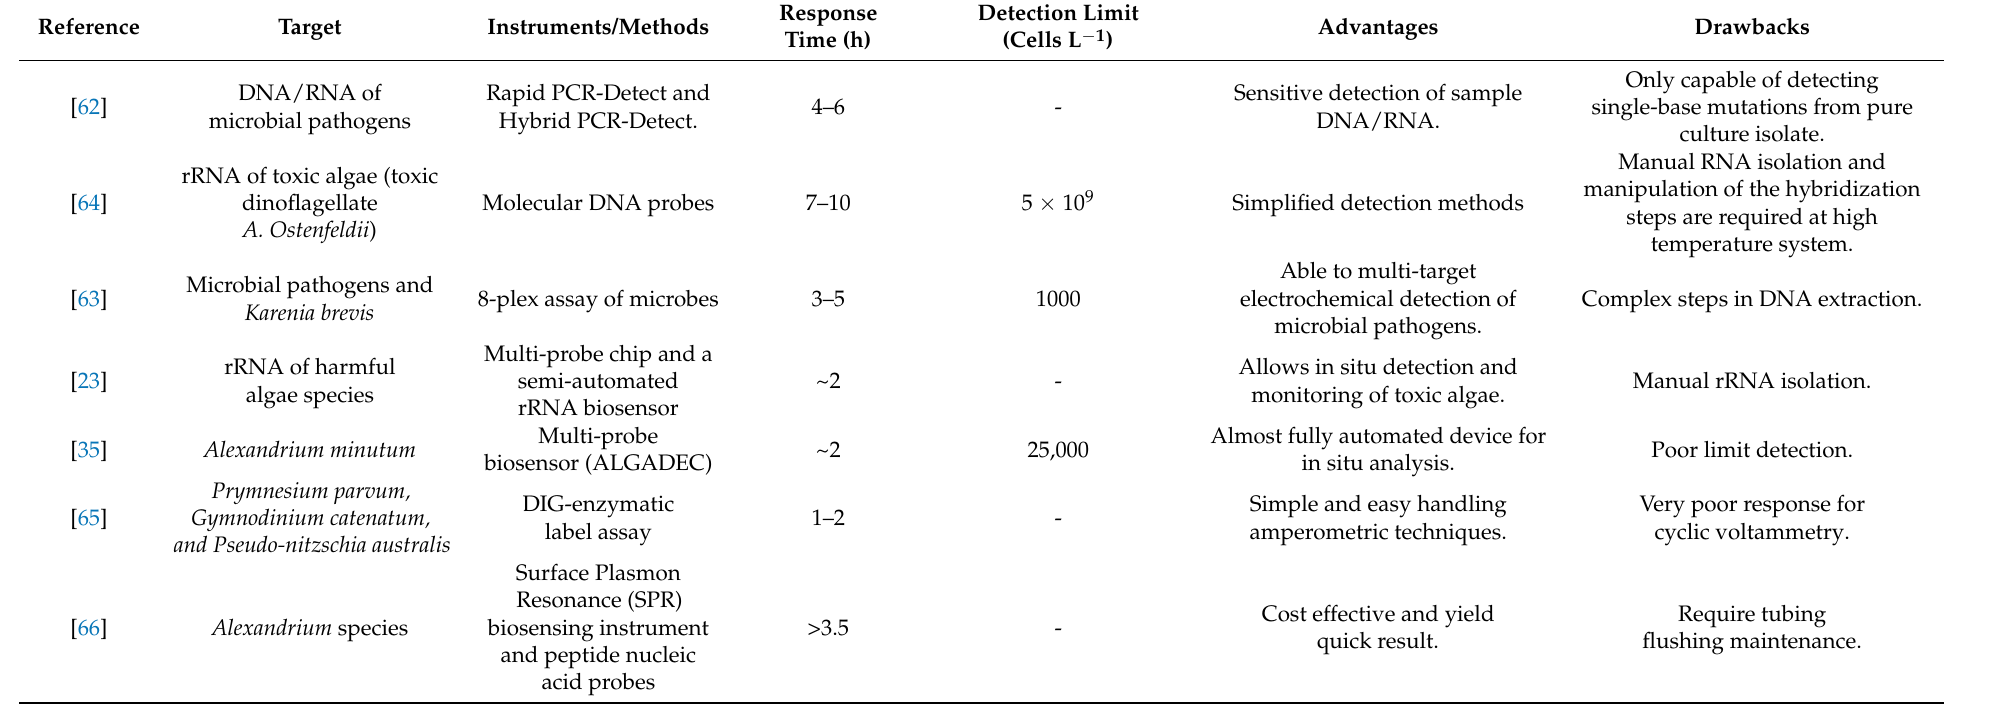
Table 2. Summary of the previously reported biosensors methods for the detection of HAB